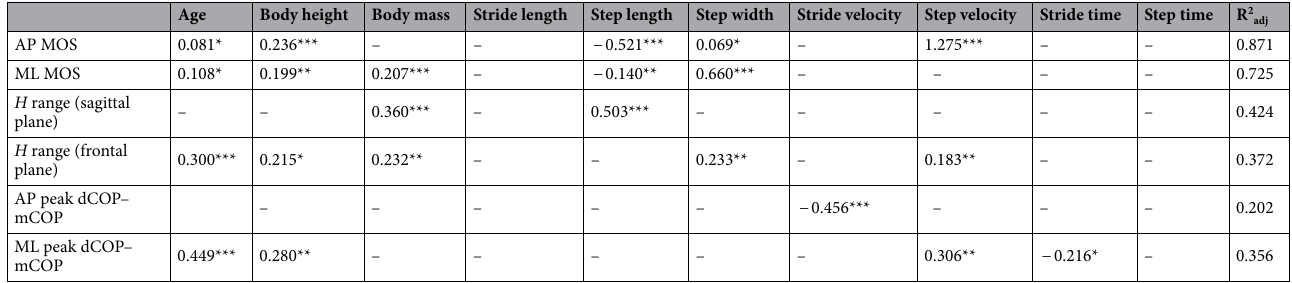
Table 2. Standardized regression coefficient of each independent variable (age, body height, body mass, and gait parameters) and adjusted coefficient of determination for stepwise multiple regression analysis for each